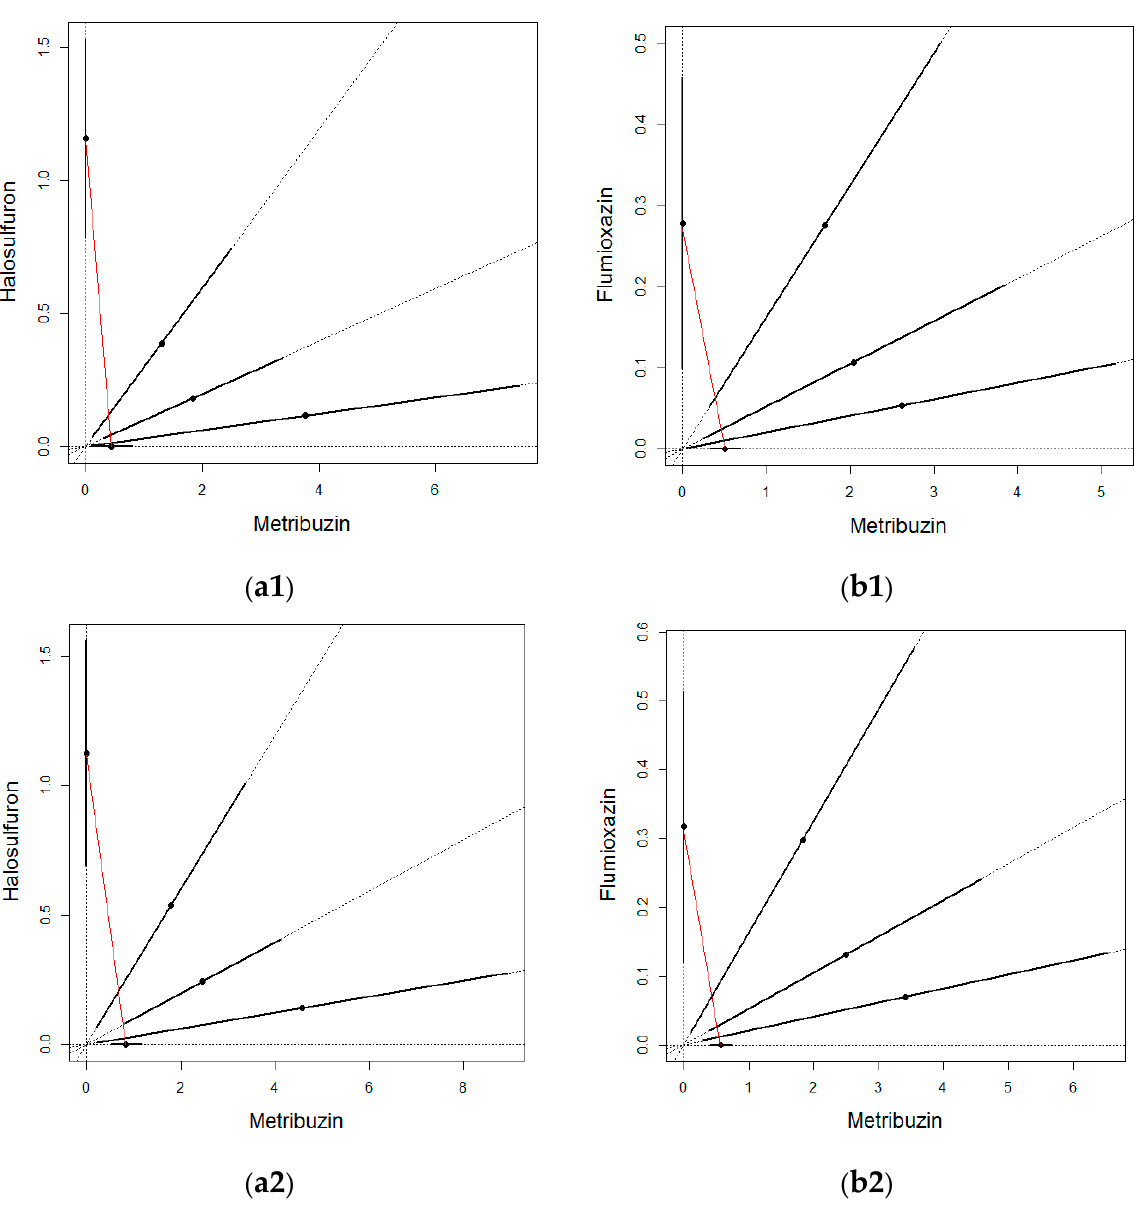
Figure 2. ED 50 isobologram showing the interactions of metribuzin:halosulfuron ( a ) and metribuzin:flumioxazin ( b ) on fresh weight A. retroflexus in the first experiment ( 1 ) and second experiment ( 2 ). The straight line of the isobologram indicates additivity. The lines around the mixture points are 95% confidence intervals.